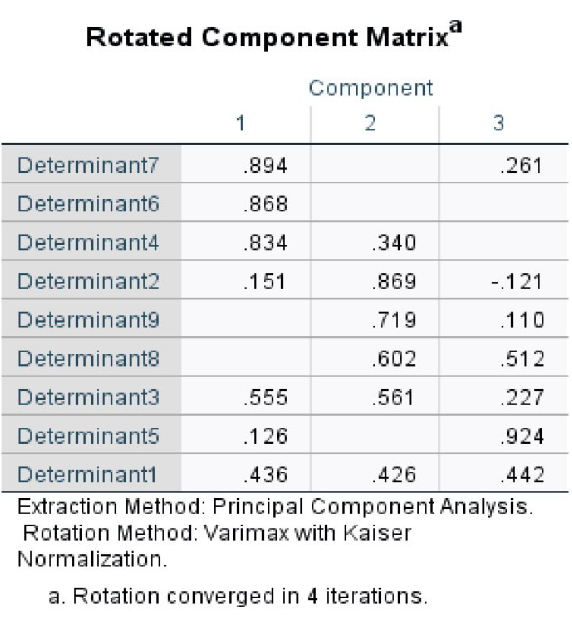
Table 6. Rotated Component Matrix (output from SPSS)